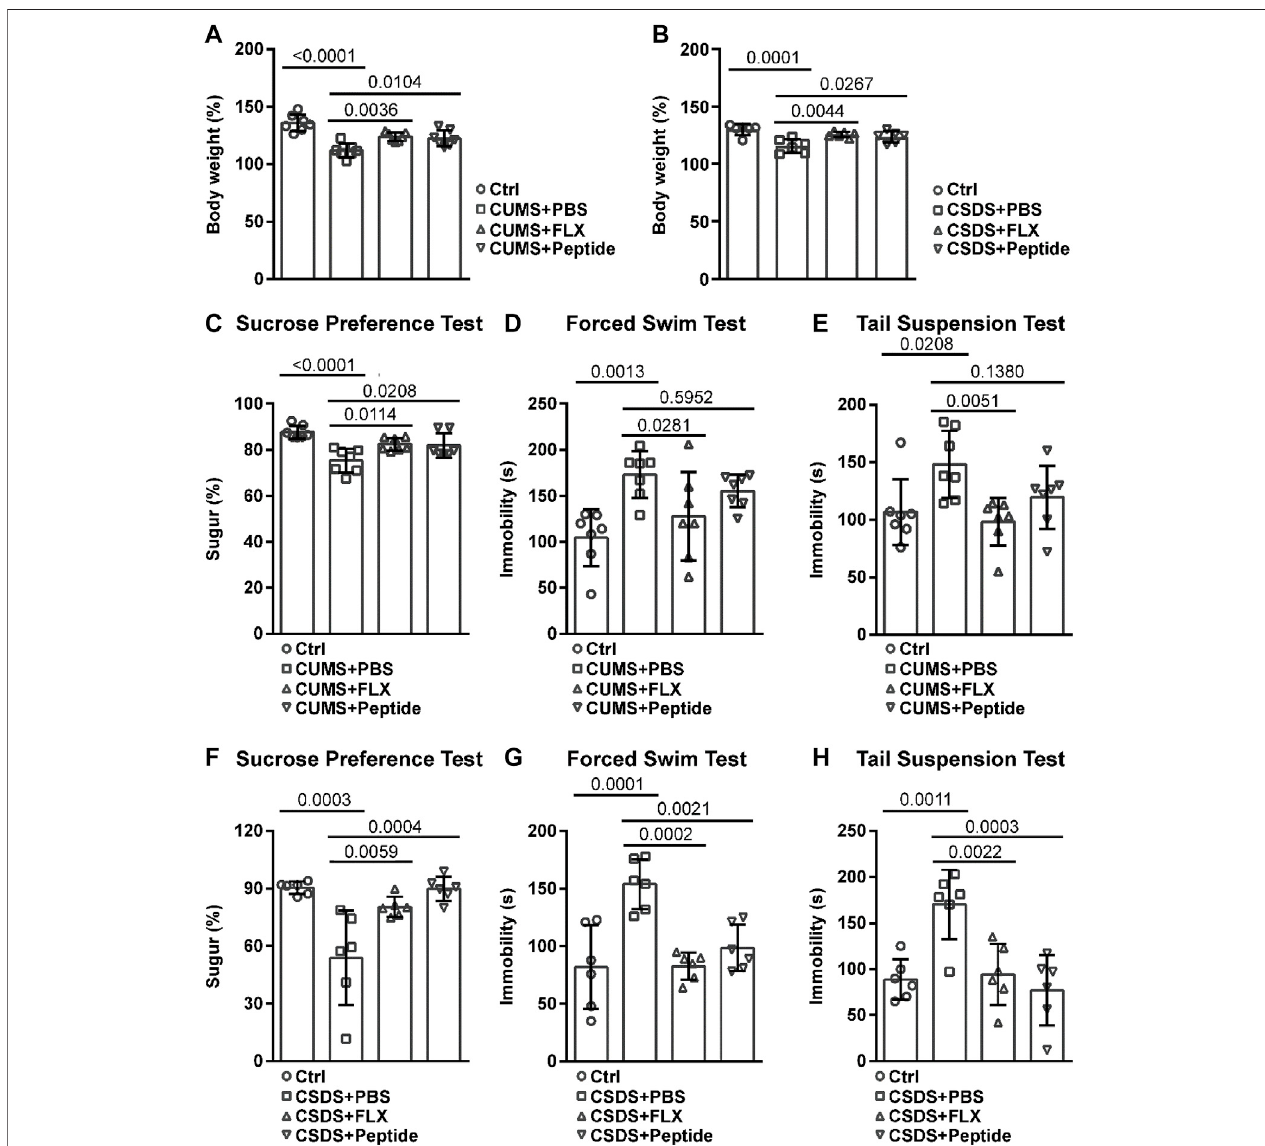
FIGURE1| ARA290reducedCUMS-andCSDS-induceddepression-likebehavior:8-week-oldmaleC57BL/6micesubjectedtotheCUMSmodel( n =7miceper group) (A and C – E) or 5-week-old male C57BL/6 mice subjected to the CSDS model ( n = 6 mice per group) (B and F – H) were intraperitoneally injected with fl uoxetine (FLX, 10 mg/kg) or ARA290 (peptide, 0.5 mg/kg) once a day during chronic stress induction. Then, the body weight change (A and B) , sucrose preference rate (C and F) ,and immobilitytime intheforcedswimtest (DandG) and thetailsuspension test (E andH) weremeasured.Thestatisticalvaluesbetweendifferentgroupsare